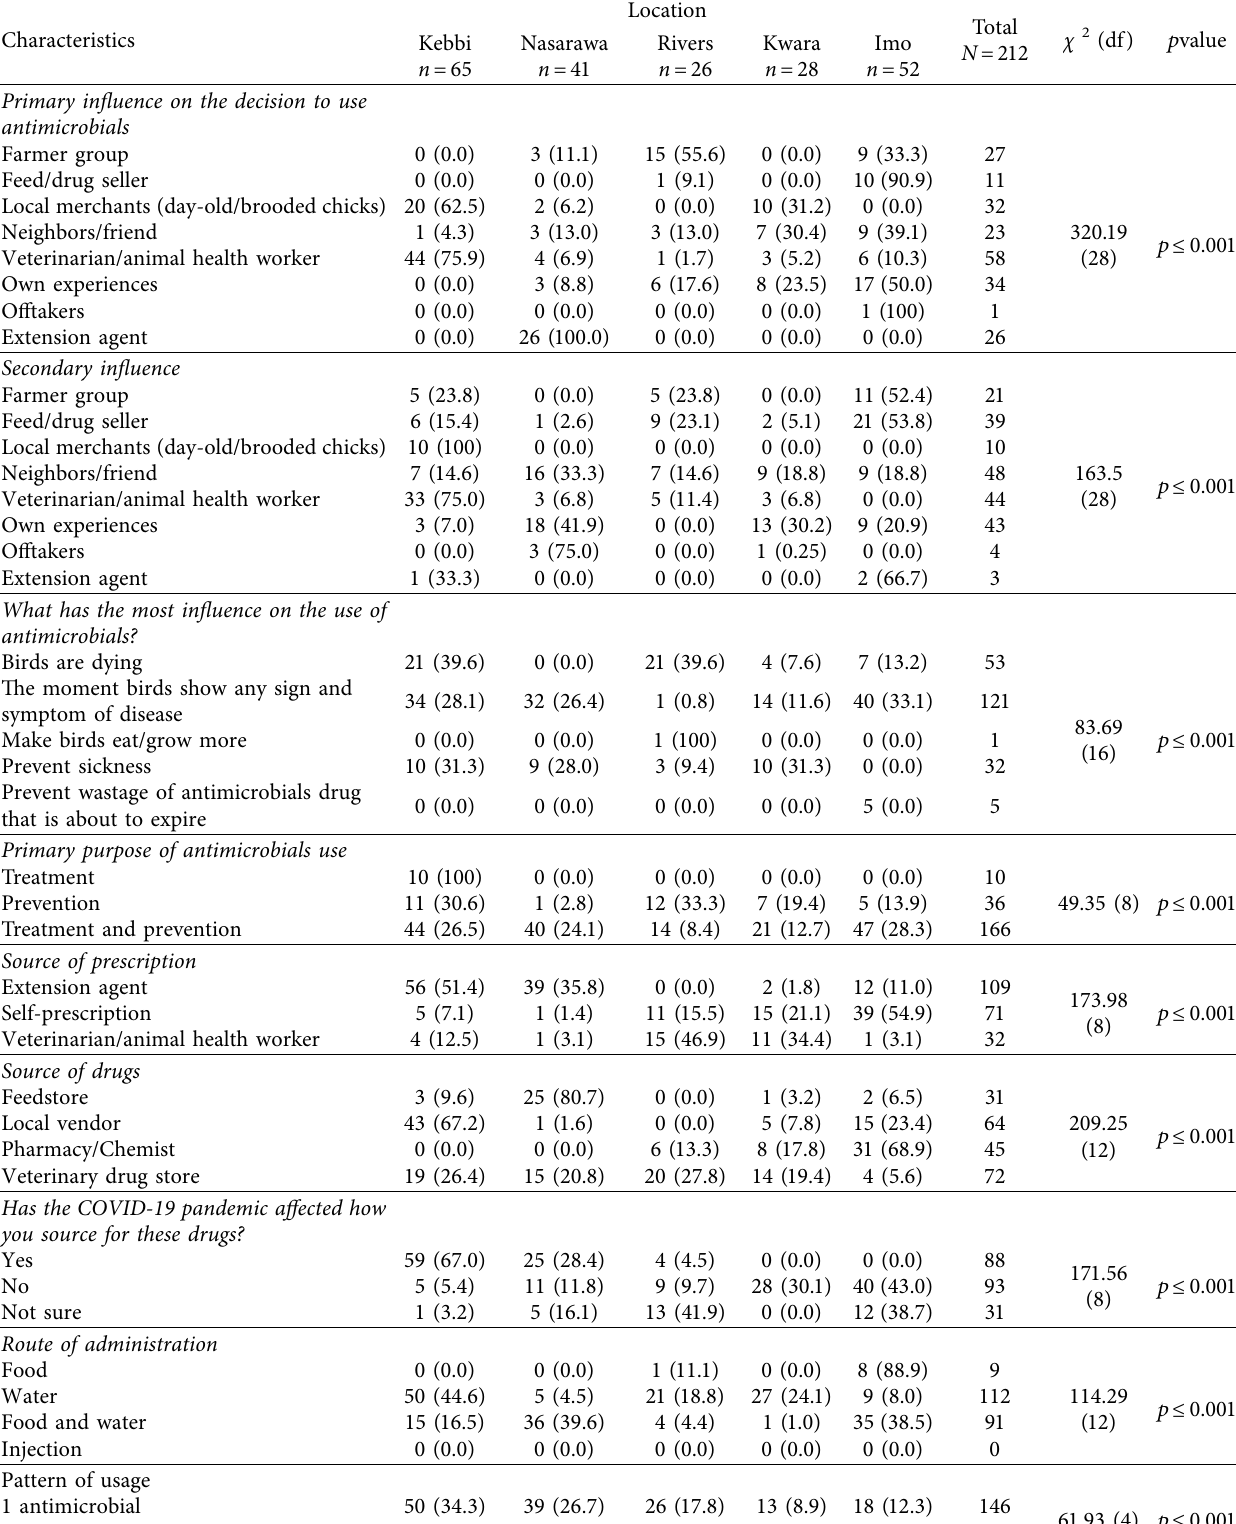
Table 5: Characteristics of farmers who used antimicrobials (western method alone, or in combination with traditional method).